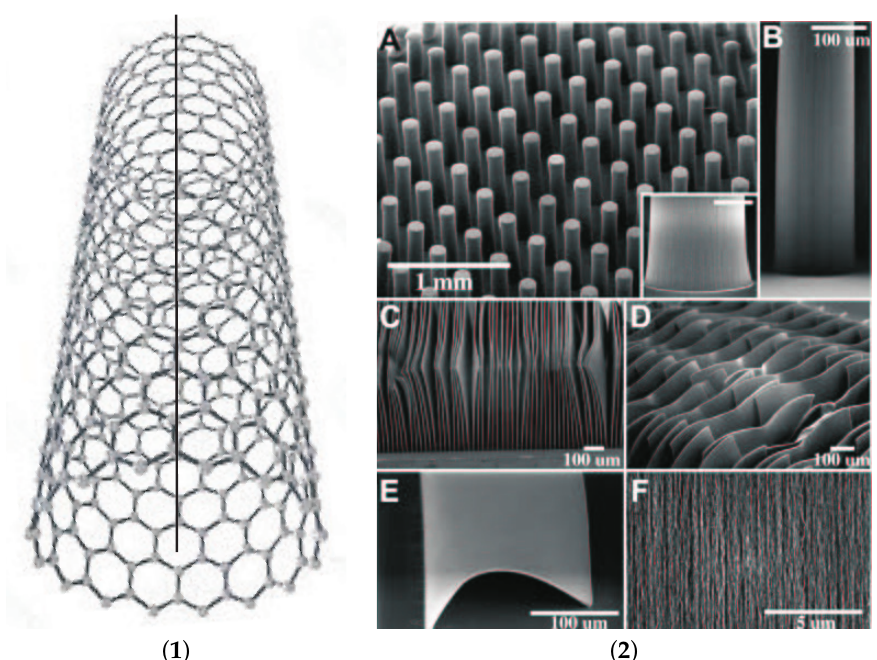
Figure 8. ( 1 ): Principal sketch of a single-wall carbon nanotube (SWCNT). ( 2 ): SEM micrographs of organized SWCNTs: ( 2 )/( A ): nanotube forest with anisotropic growth, ( 2 )/( B ): very smooth surface of the trees; ( 2 )/( C , D ): the leaves prove: no steric obstacles during growth; ( 2 )/( E ): a single leaf; ( 2 )/( F ): surface of a leaf [37] (with kind permission from Science,